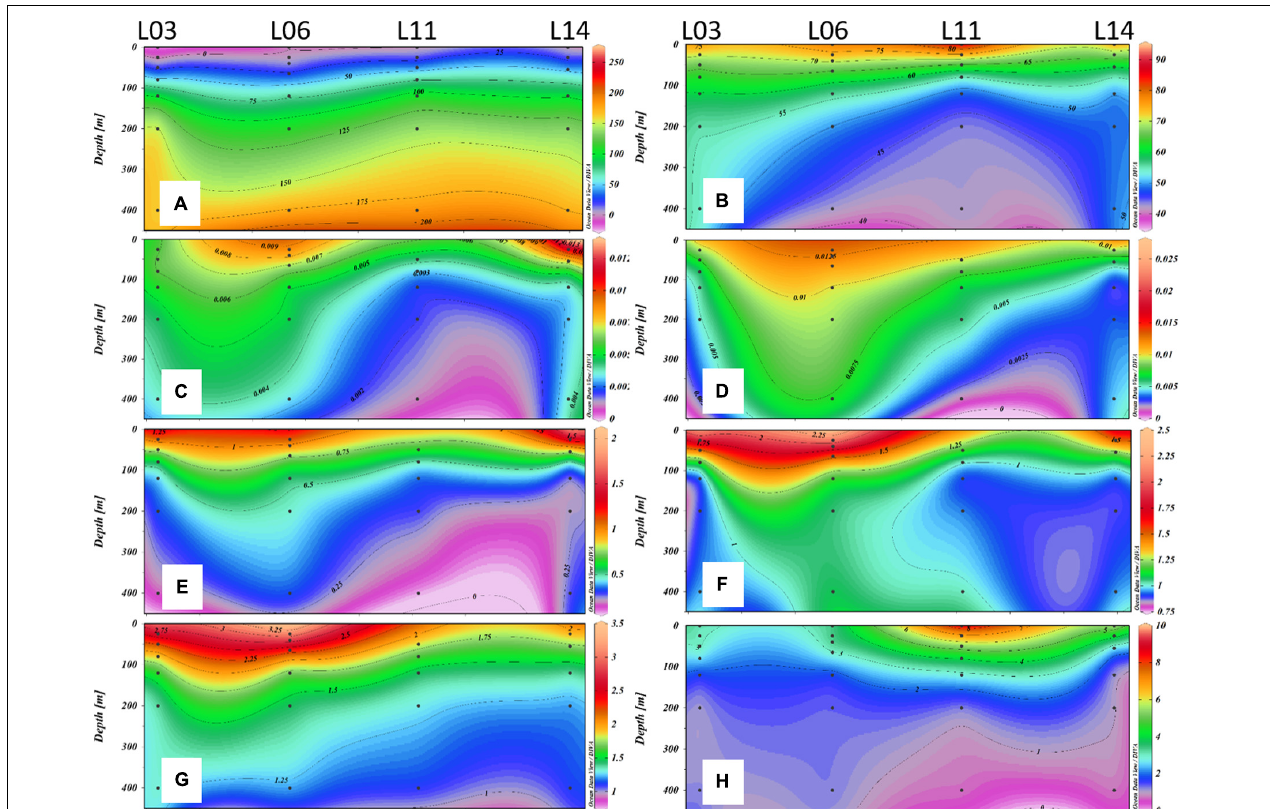
FIGURE 4 | Distribution of AOU ( µ mol L − 1 ) (A) , DOC ( µ mol L − 1 ) (B) , C4 (R.U.) (C) , C5 (R.U.) (D) , (cid:54) P/ (cid:54) H (E) , A/C (F) , M/C (G) , and POC ( µ mol L − 1 ) (H) of section C in June 2015.